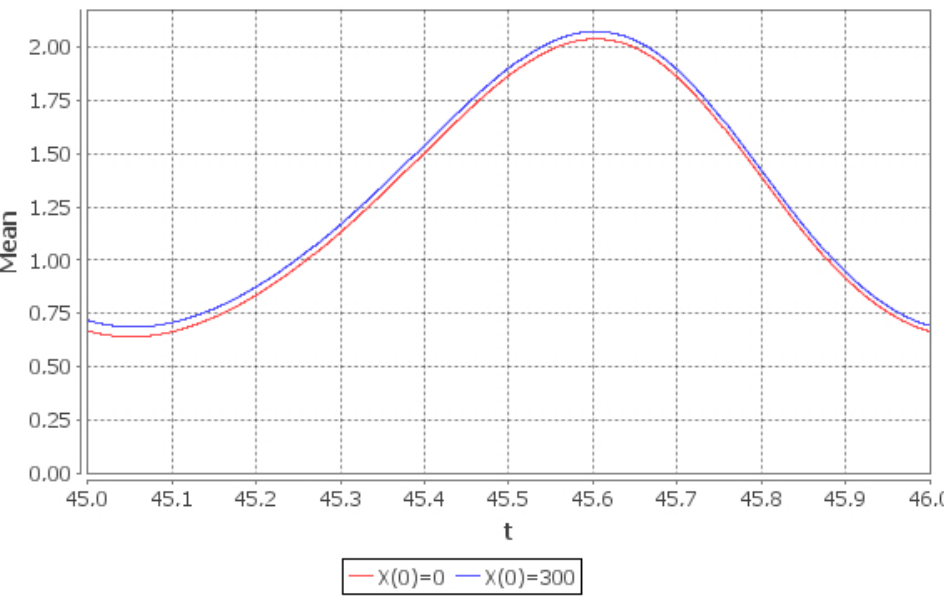
Figure 12. Limiting conditional mean E ( t , k ) number of customers in the system: E ( t ,0 ) ( red line ), E ( t ,300 ) ( blue line